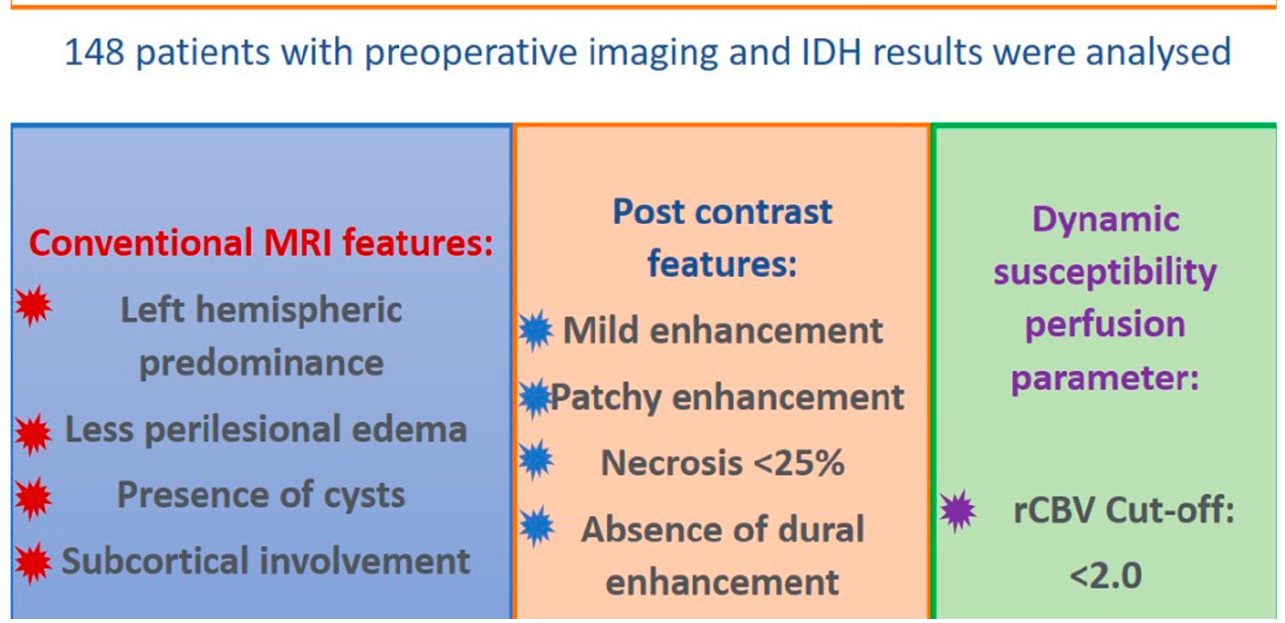
Figure 12. Pictorial depiction of the results of our